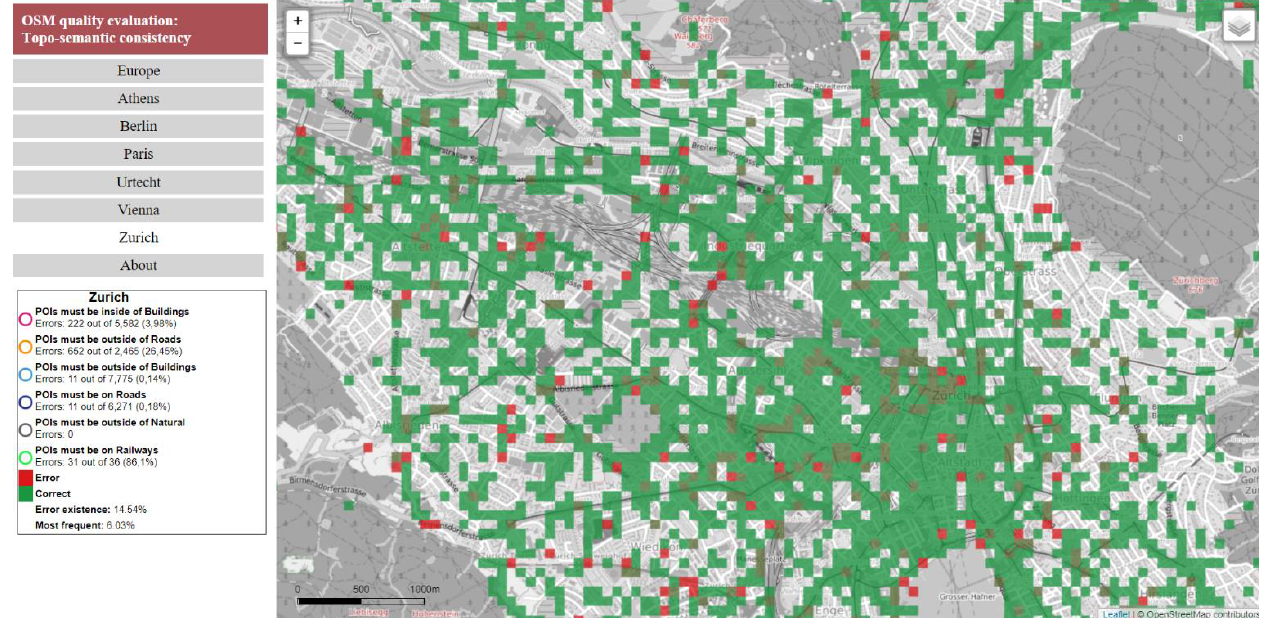
When the user selects one of the cities from the left side menu, the map zooms to the